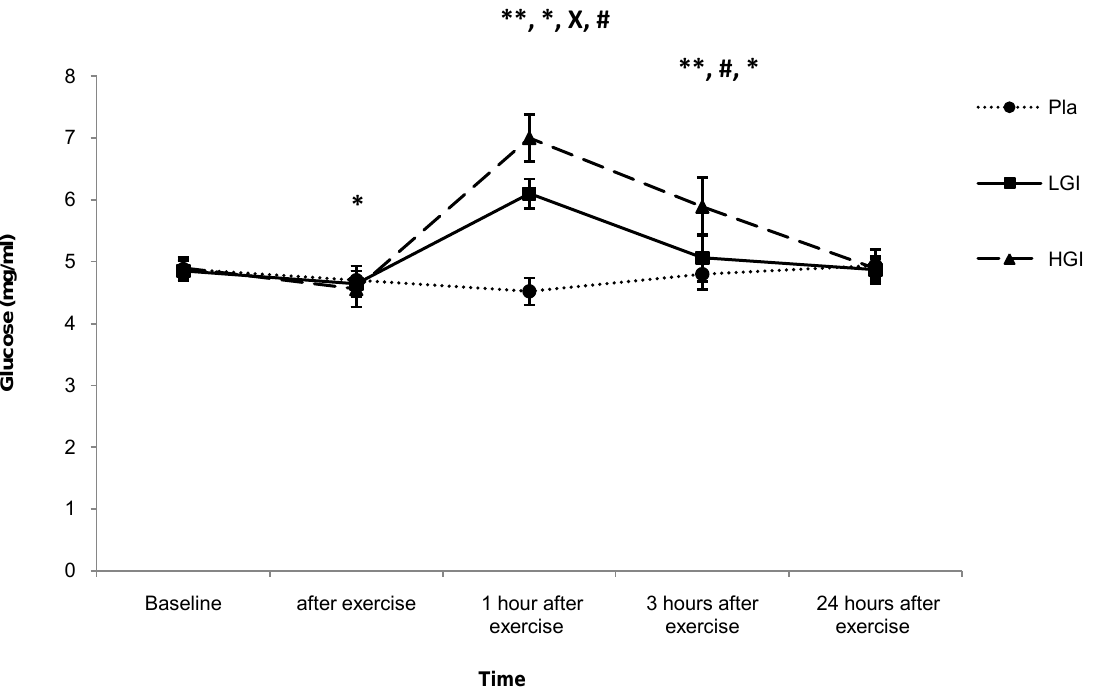
Fig.3. Mean concentration of serum glucose for Pla, LGI and HGI diet groups at the various time points. Significant differences between Pla and LGI (treatment effect) are indicated with (X) where P <0.05; Significant differences between Pla and HGI (treatment effect) are indicated with (**) where P < 0.05; Significant differences between LGI and HGI (treatment effect) are indicated with (#) where P < 0.05; Significant differences from baseline (time effect) are denoted by (*) where P < 0.05. Solid black bar represents resistance exercise bout; Pla = placebo, LGI = Low glycemic index, HGI = High glycemic index. Values are mean ±